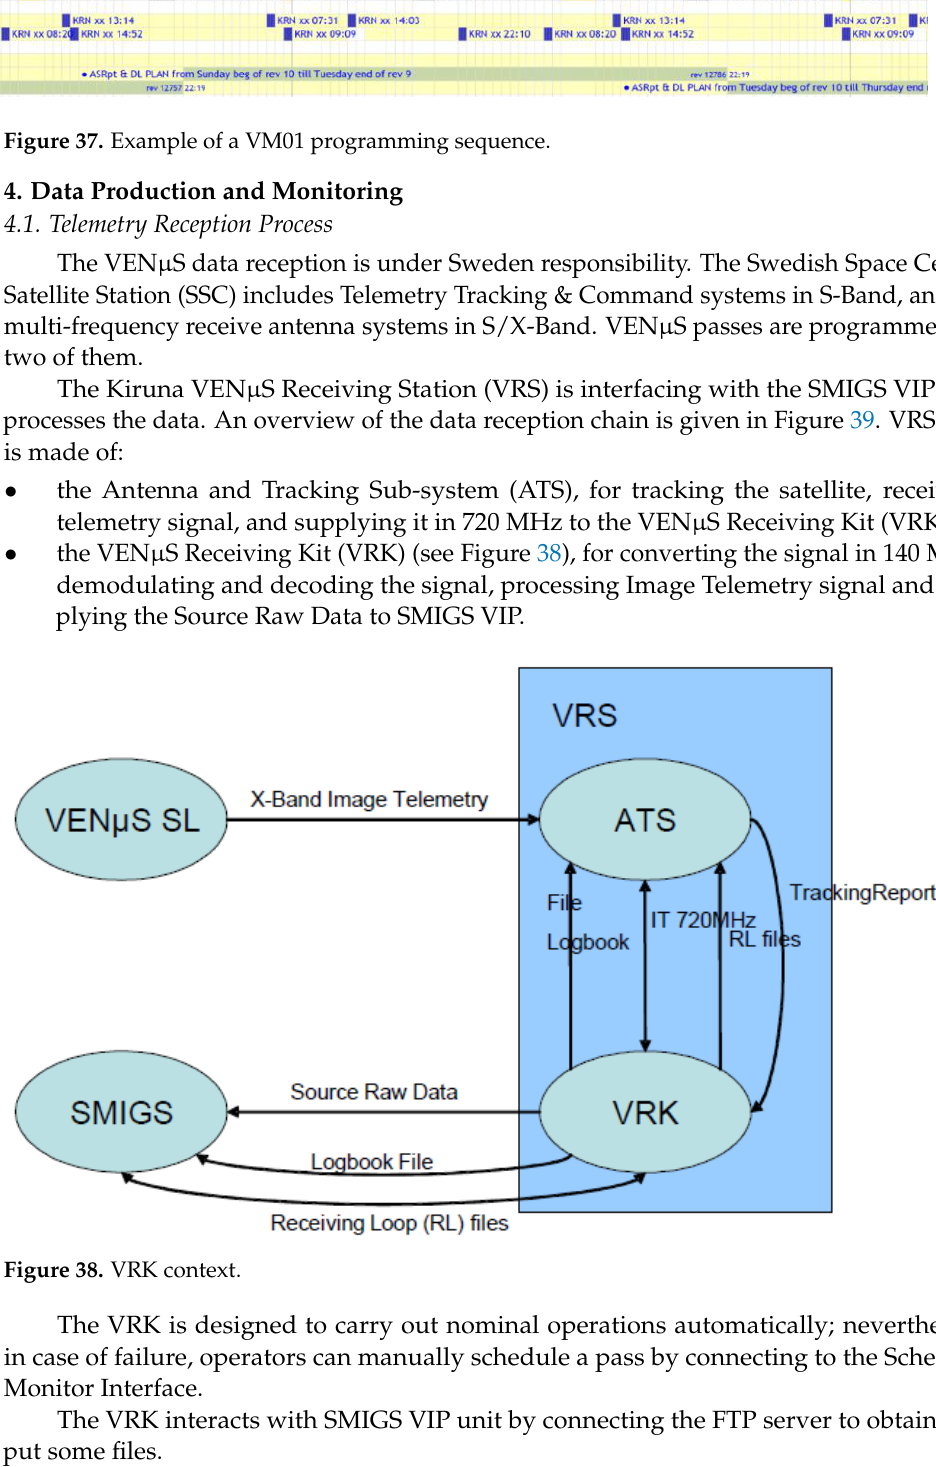
Figure 38. Data reception chain overview.